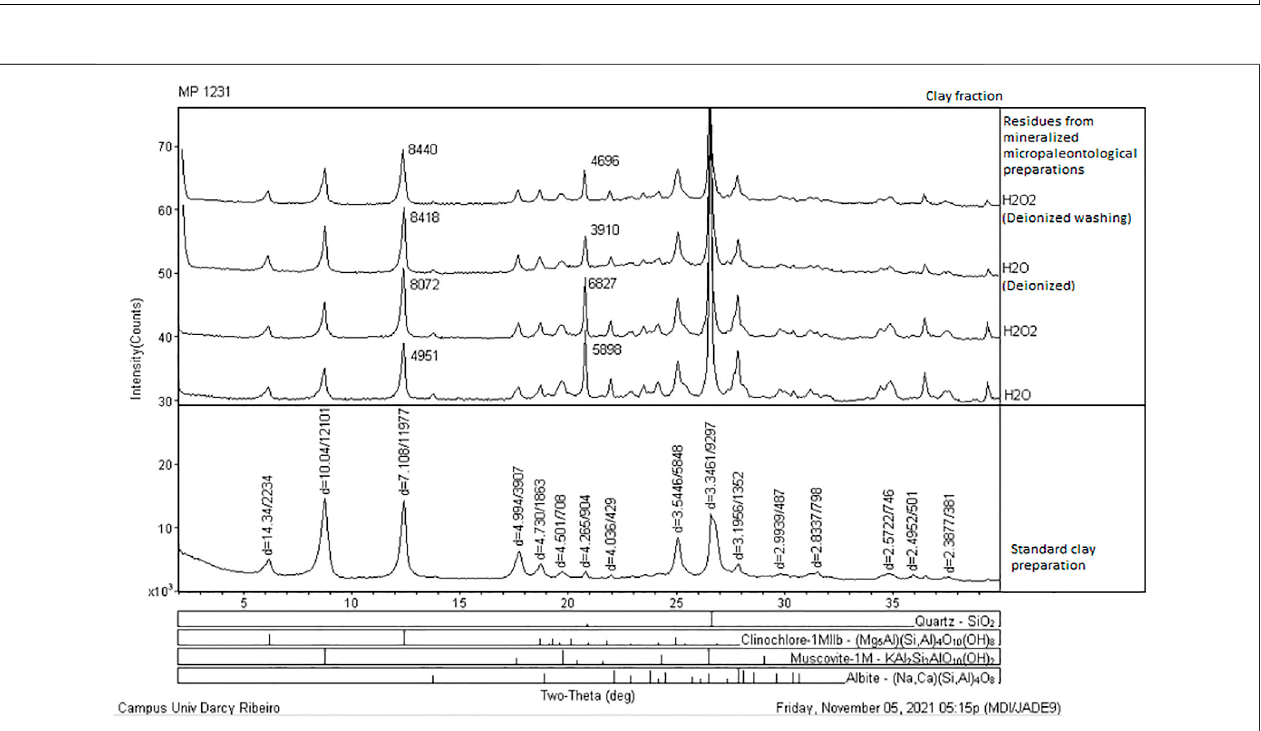
FIGURE 9 | Diffractogram of the sample MP1231 from Bambuí Group, Municipality of Buritis, Minas Gerais State, Brazil. Clay fraction (n); note the variation in re fl ection intensities between the diffractogram of untreated sample (base) and treated samples; note that all treatments have the same effect on the clay fraction.